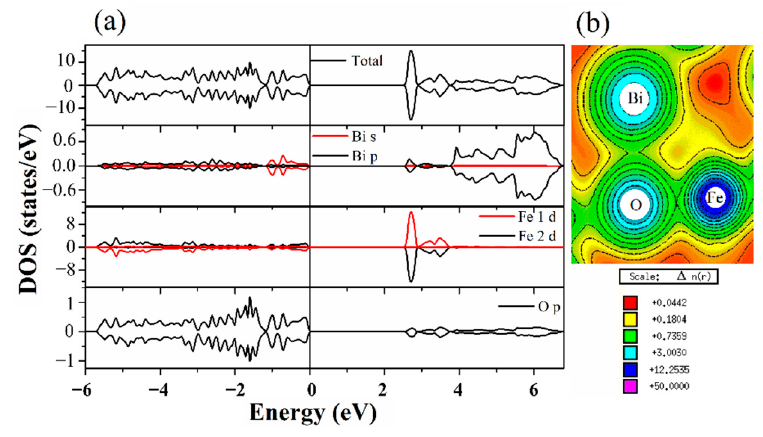
Figure 10. ( a ) Total and partial density of electronic states, and ( b ) the charge density distribution (110 plan) of the bulk BiFeO 3 compound.